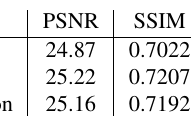
Figure 8. The results of deblurring by GWIS algorithm with the proposed blur parameter estimation algorithm for the testing dataset.